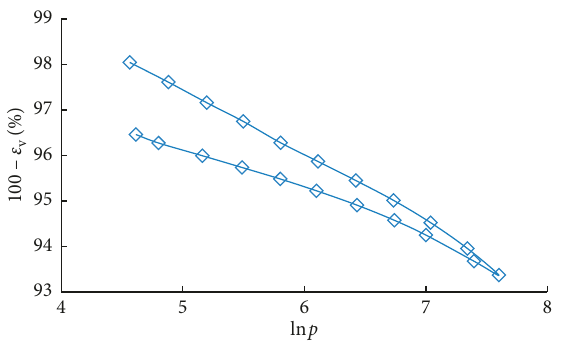
Figure 4: Frozen sandy soil rebound test